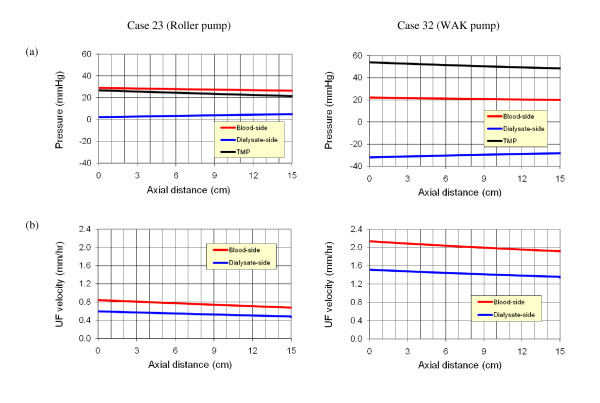
The pressure and ultrafiltration velocity distribution along the blood and dialysate compartments of the dialyzer's membrane (computational results). The TMP induced by the WAK pump is about twice of the roller pump and so is the ultrafiltration velocity.